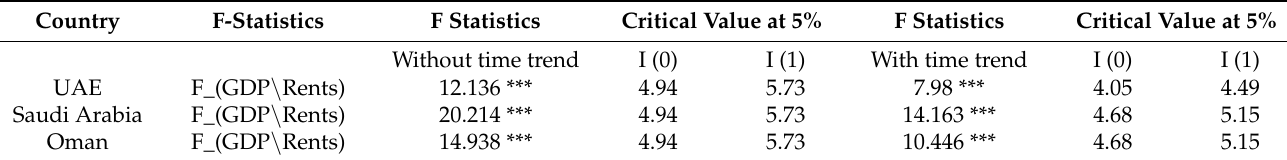
Table 5. ARDL Bound Cointegration test.